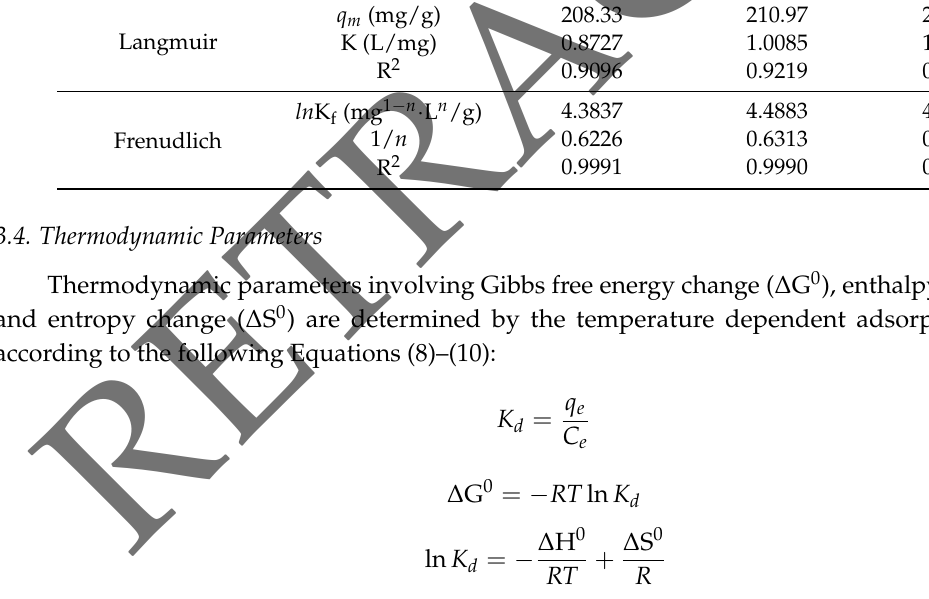
Figure 3. ( A ) Langmuir isotherm plots of Zn(II) adsorption on GO; ( B ) The Freundlich isotherm plots of Zn(II) adsorption on GO. Table 1. Relative parameters of the Langmuir and Frenudlich isotherm models. Isotherm Models